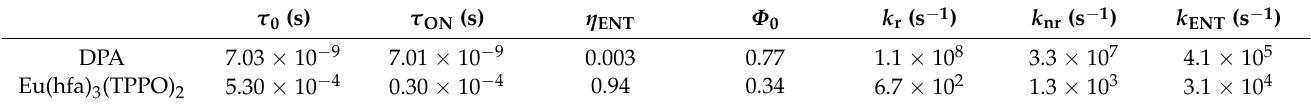
Table 1. Photophysical parameters of the DPA and Eu(hfa) 3 (TPPO) 2 in the electrofluorochromic